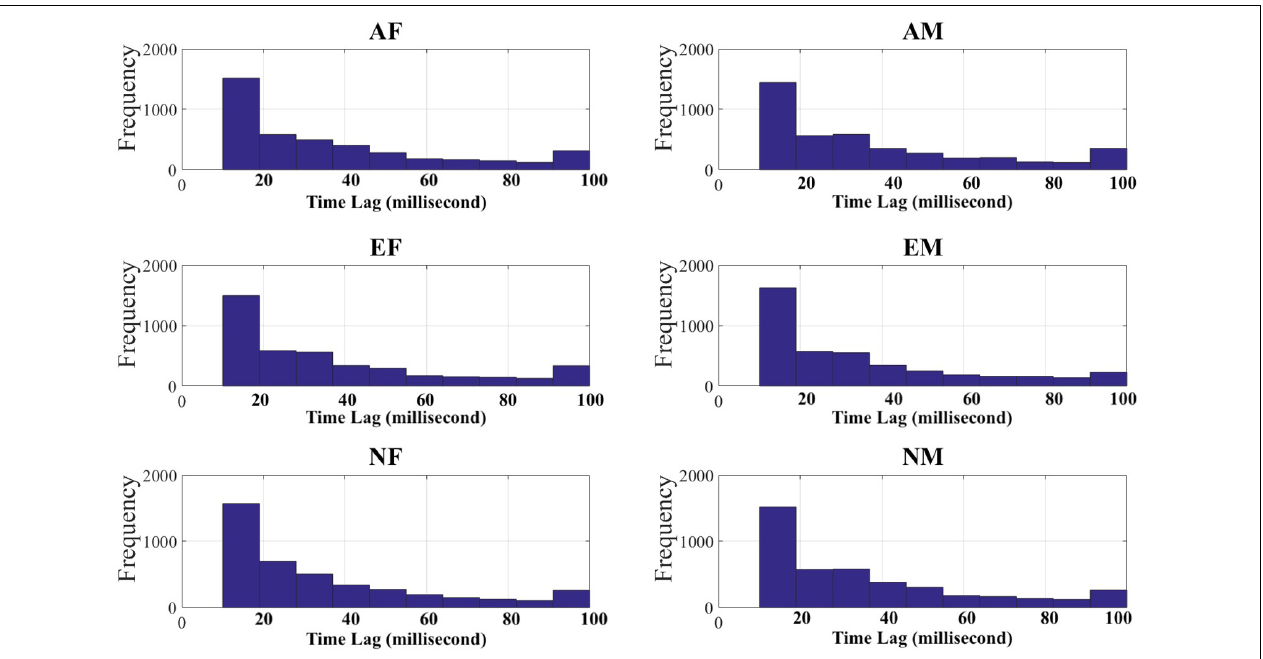
FIGURE 2 | Time lags (in millisecond) associated with maximum transfer entropy (TEs) between every pairs of EEG channels in androgen–female storyteller (AF), androgen–male storyteller (AM), Estr–female voice (EF), estrogen–male storyteller (EM), neuter–female voice (NF), and neuter–male voice (NM) experimental settings.